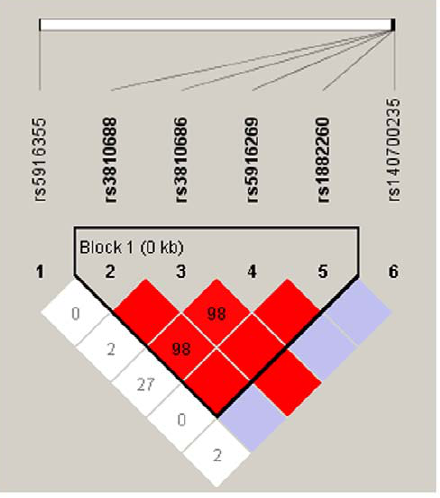
Figure 1. Linkage disequilibrium block of NLGN4 gene. The color of each square from light to dark represents the level of LD from low to high. White: complete recombination; blue: partial linkage; red: complete linkage.